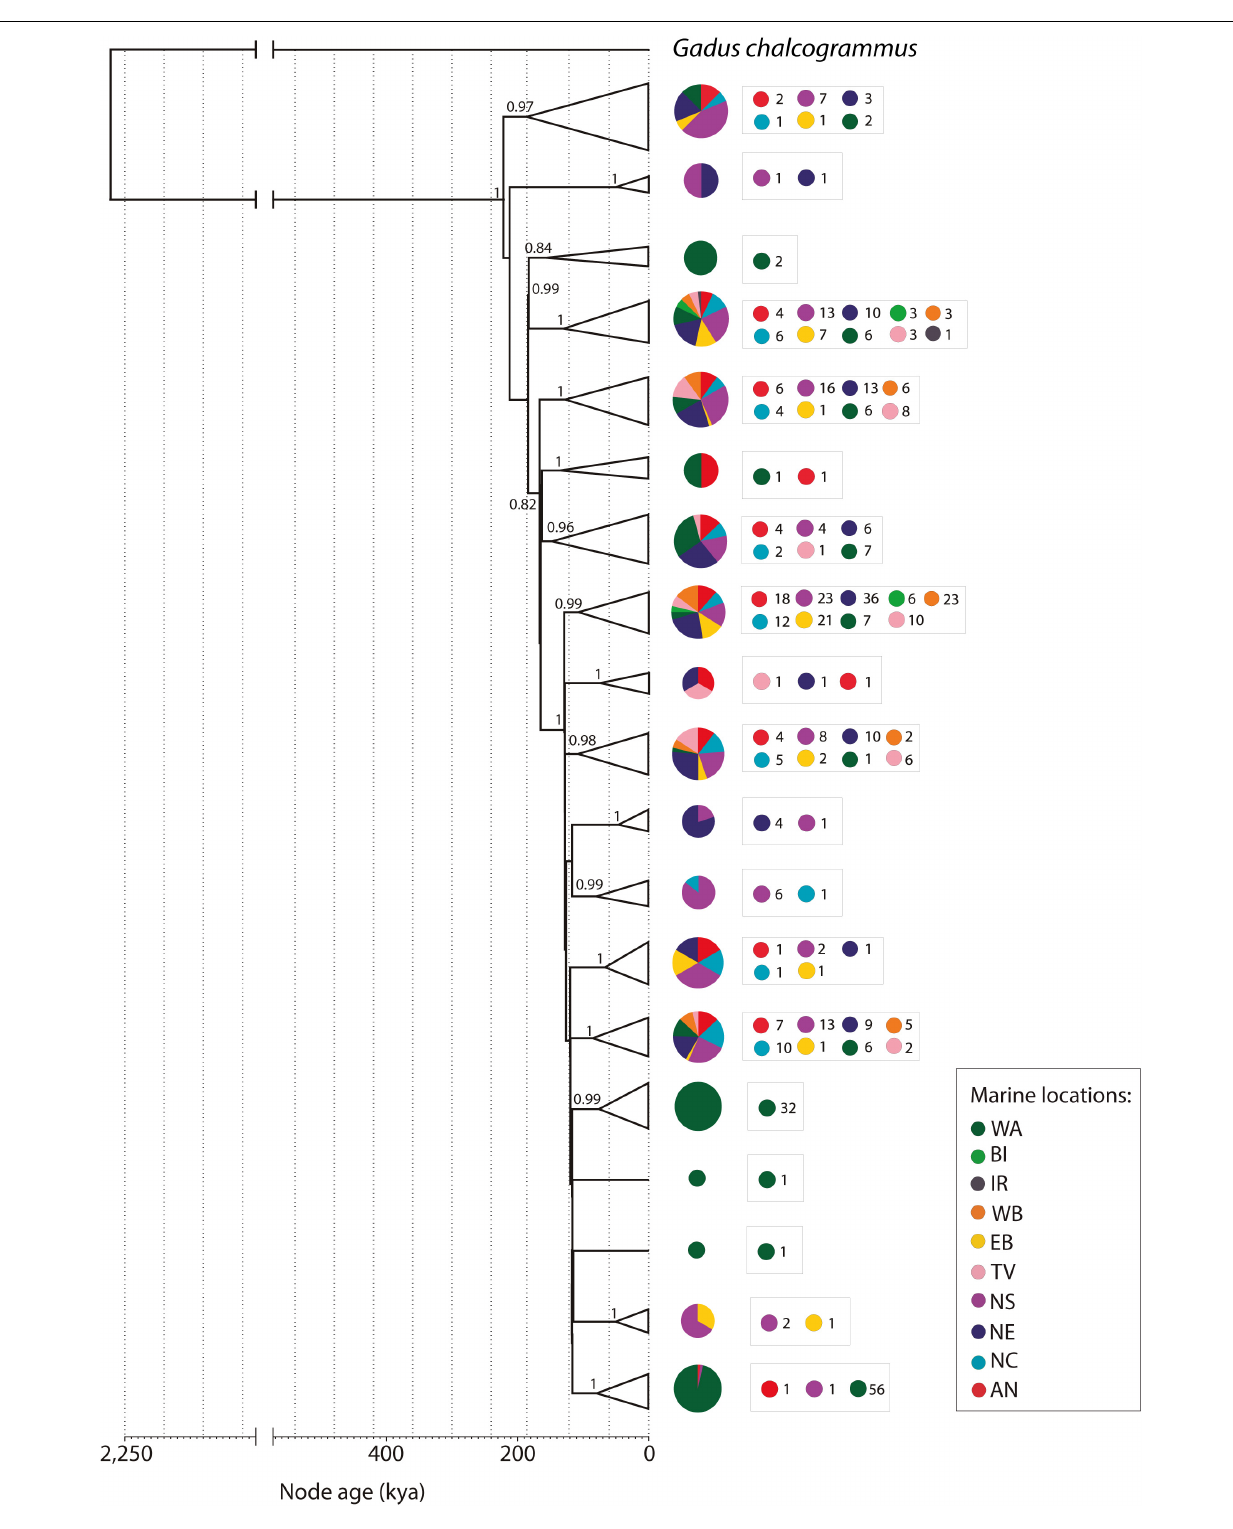
Frontiers in Ecology and Evolution |